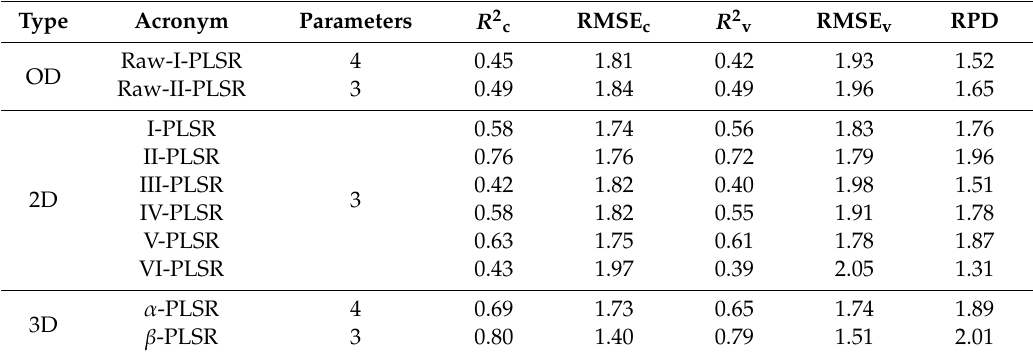
Table 4. The contrast of estimation models with soil salinity (ds · m − 1 ).